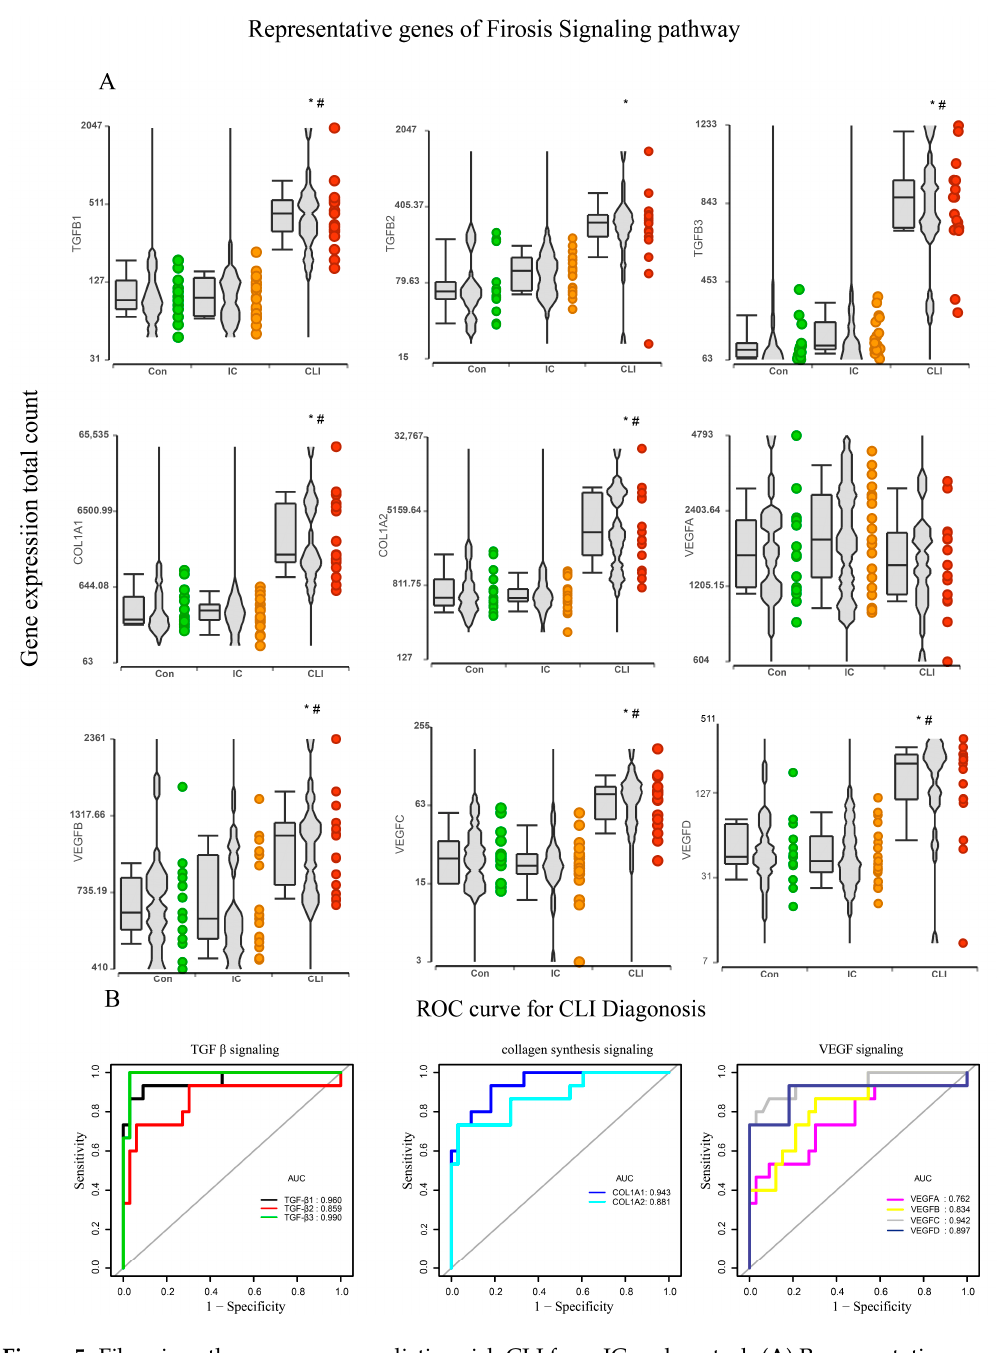
Figure 5. Fibrosis pathway core genes distinguish CLI from IC and control. ( A ) Representative gene expression of fibrosis pathway by transcriptomic by box and whiskers, violins, and points plot; each dot is a sample. The plot title is the gene symbol of the selected gene. Expression levels are log (total counts) on the vertical axis. * p < 0.05, compared with non-PAD controls by wald test, # p < 0.05, compared with IC by wald test. ( B ) Receiver operating curve (ROC) (spell out ROC) for the diagnosis of CLI of TGF β signaling, collagen deposition signaling, and vascular endothelial growth factor (VEGF) signaling. All area under curve (AUC) > 0.75. N = 15 for non-PAD control, N = 20 for IC, and N = 16 for